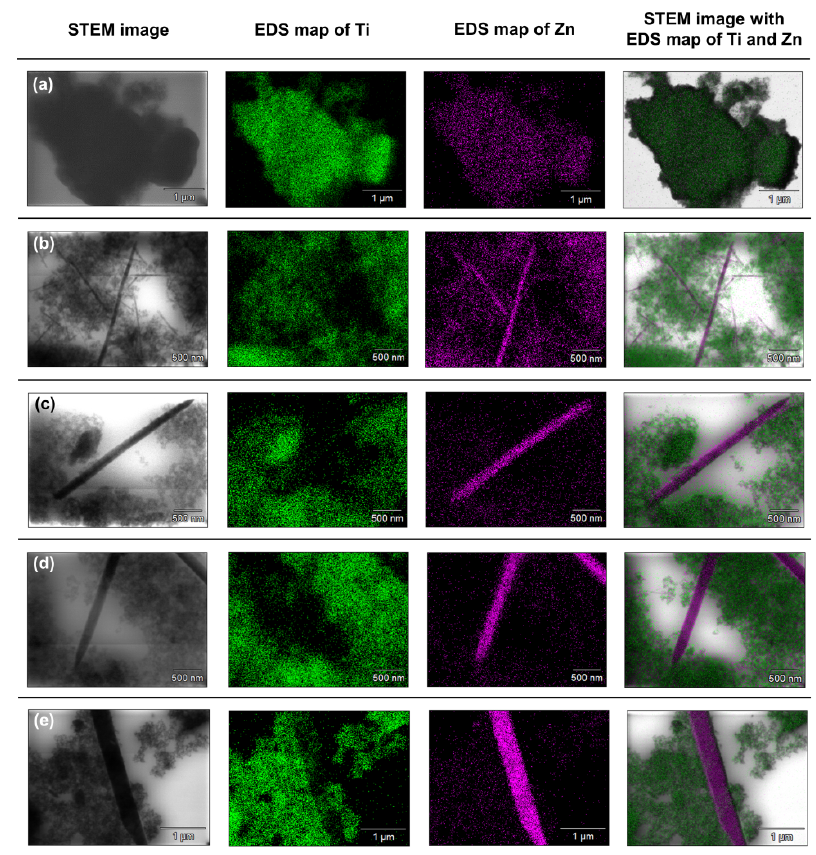
12 of 26 Figure 7. The HRTEM and FFT images for: ( a ) TiO 2 -(5%)ZnO; ( b ) TiO 2 -(10%)ZnO; ( c ) TiO 2 - (15%)ZnO. Based on the presented HRTEM and FFT images, the high crystallinity of the ana- lyzed systems was confirmed due to observed crystallographic spacing. It was found that